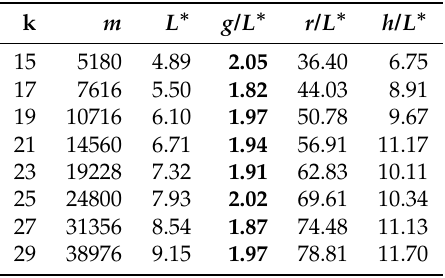
Table 7. Results for